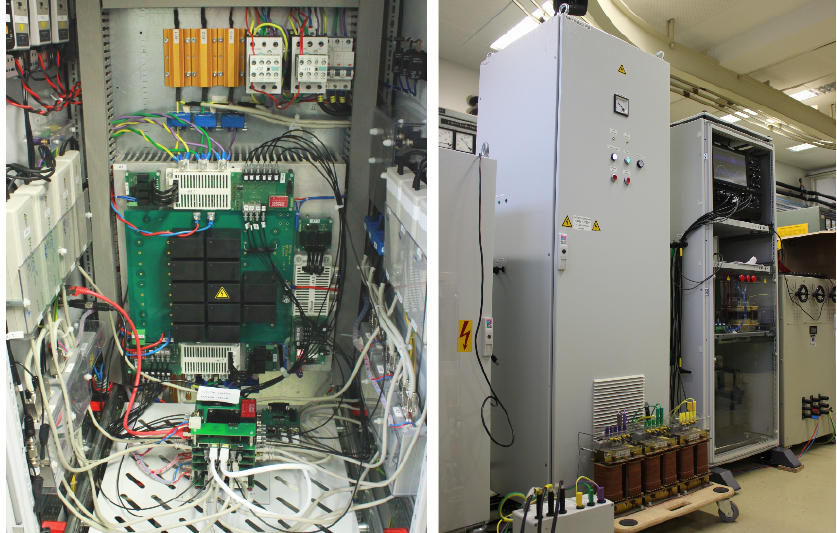
Figure 7. Photos of the experimental